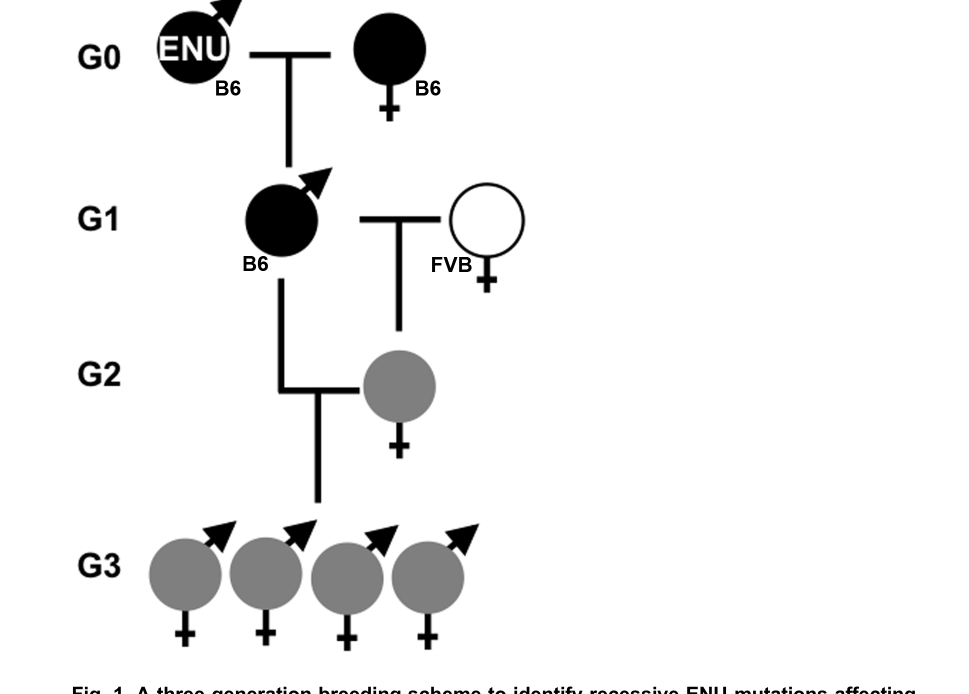
Fig. 1. A three-generation breeding scheme to identify recessive ENU mutations affecting organogenesis. Generation 0 (G0) B6 males are treated with ENU and mated to untreated B6 females to create G1 males. Each G1 establishes an independent pedigree and is mated with FVB females (white) to create G2 females. The resulting G2 females are potential heterozygous carriers of an ENU mutation and obligate heterozygotes at all FVB and B6 SNPs (grey). These G2 females are backcrossed to the G1 and sacrificed to analyze the G3 generation at E18.5. B6 5 C57BL/6J; FVB 5 FVB/NJ.